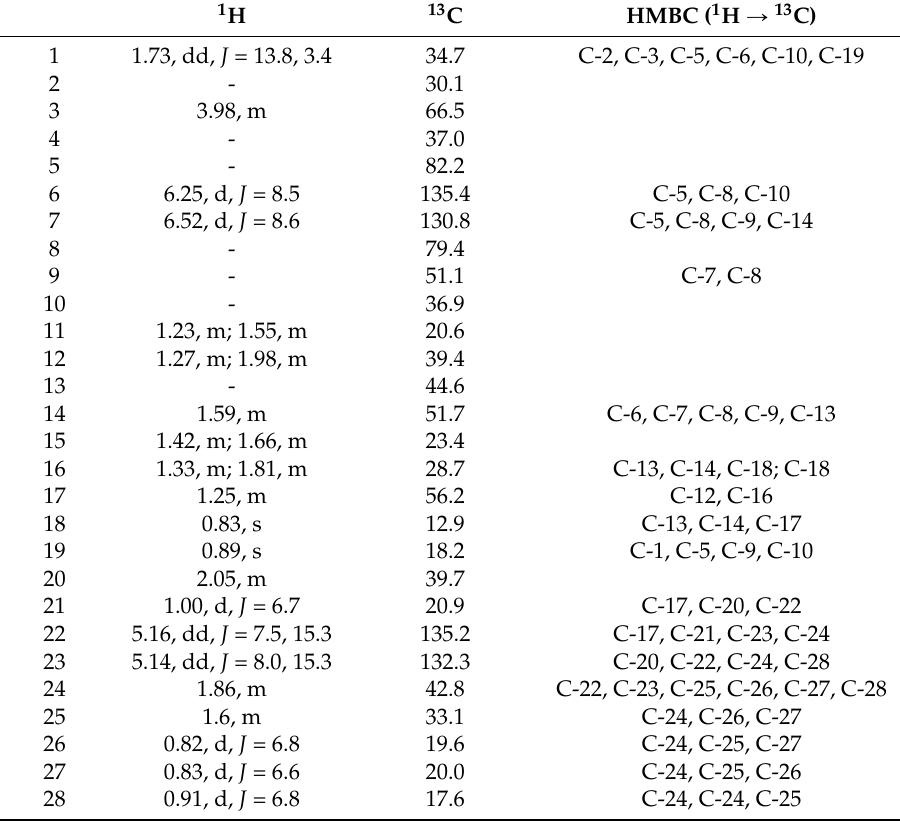
Table 1. 1 H- and 13 C-NMR data, and 1 H– 13 C HMBC correlation for ergosterol peroxide ( 1 , 500 MHz, CDCl 3 , δ in ppm, J in